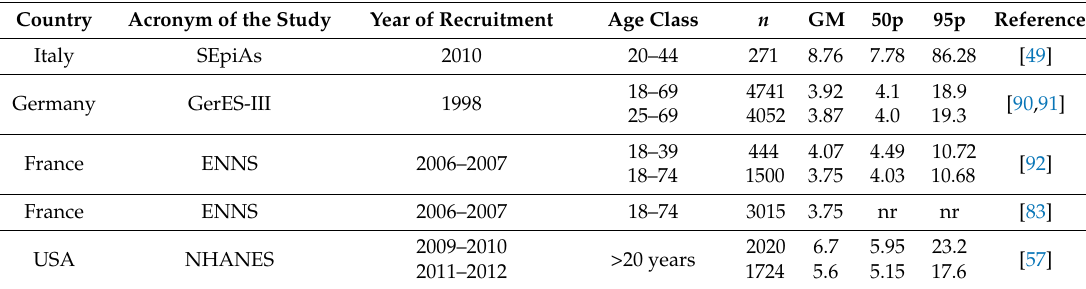
Table 8. Geometric mean, 50p and 95p values for u(iAs+MMA+DMA) concentration in our study and in other studies reporting reference